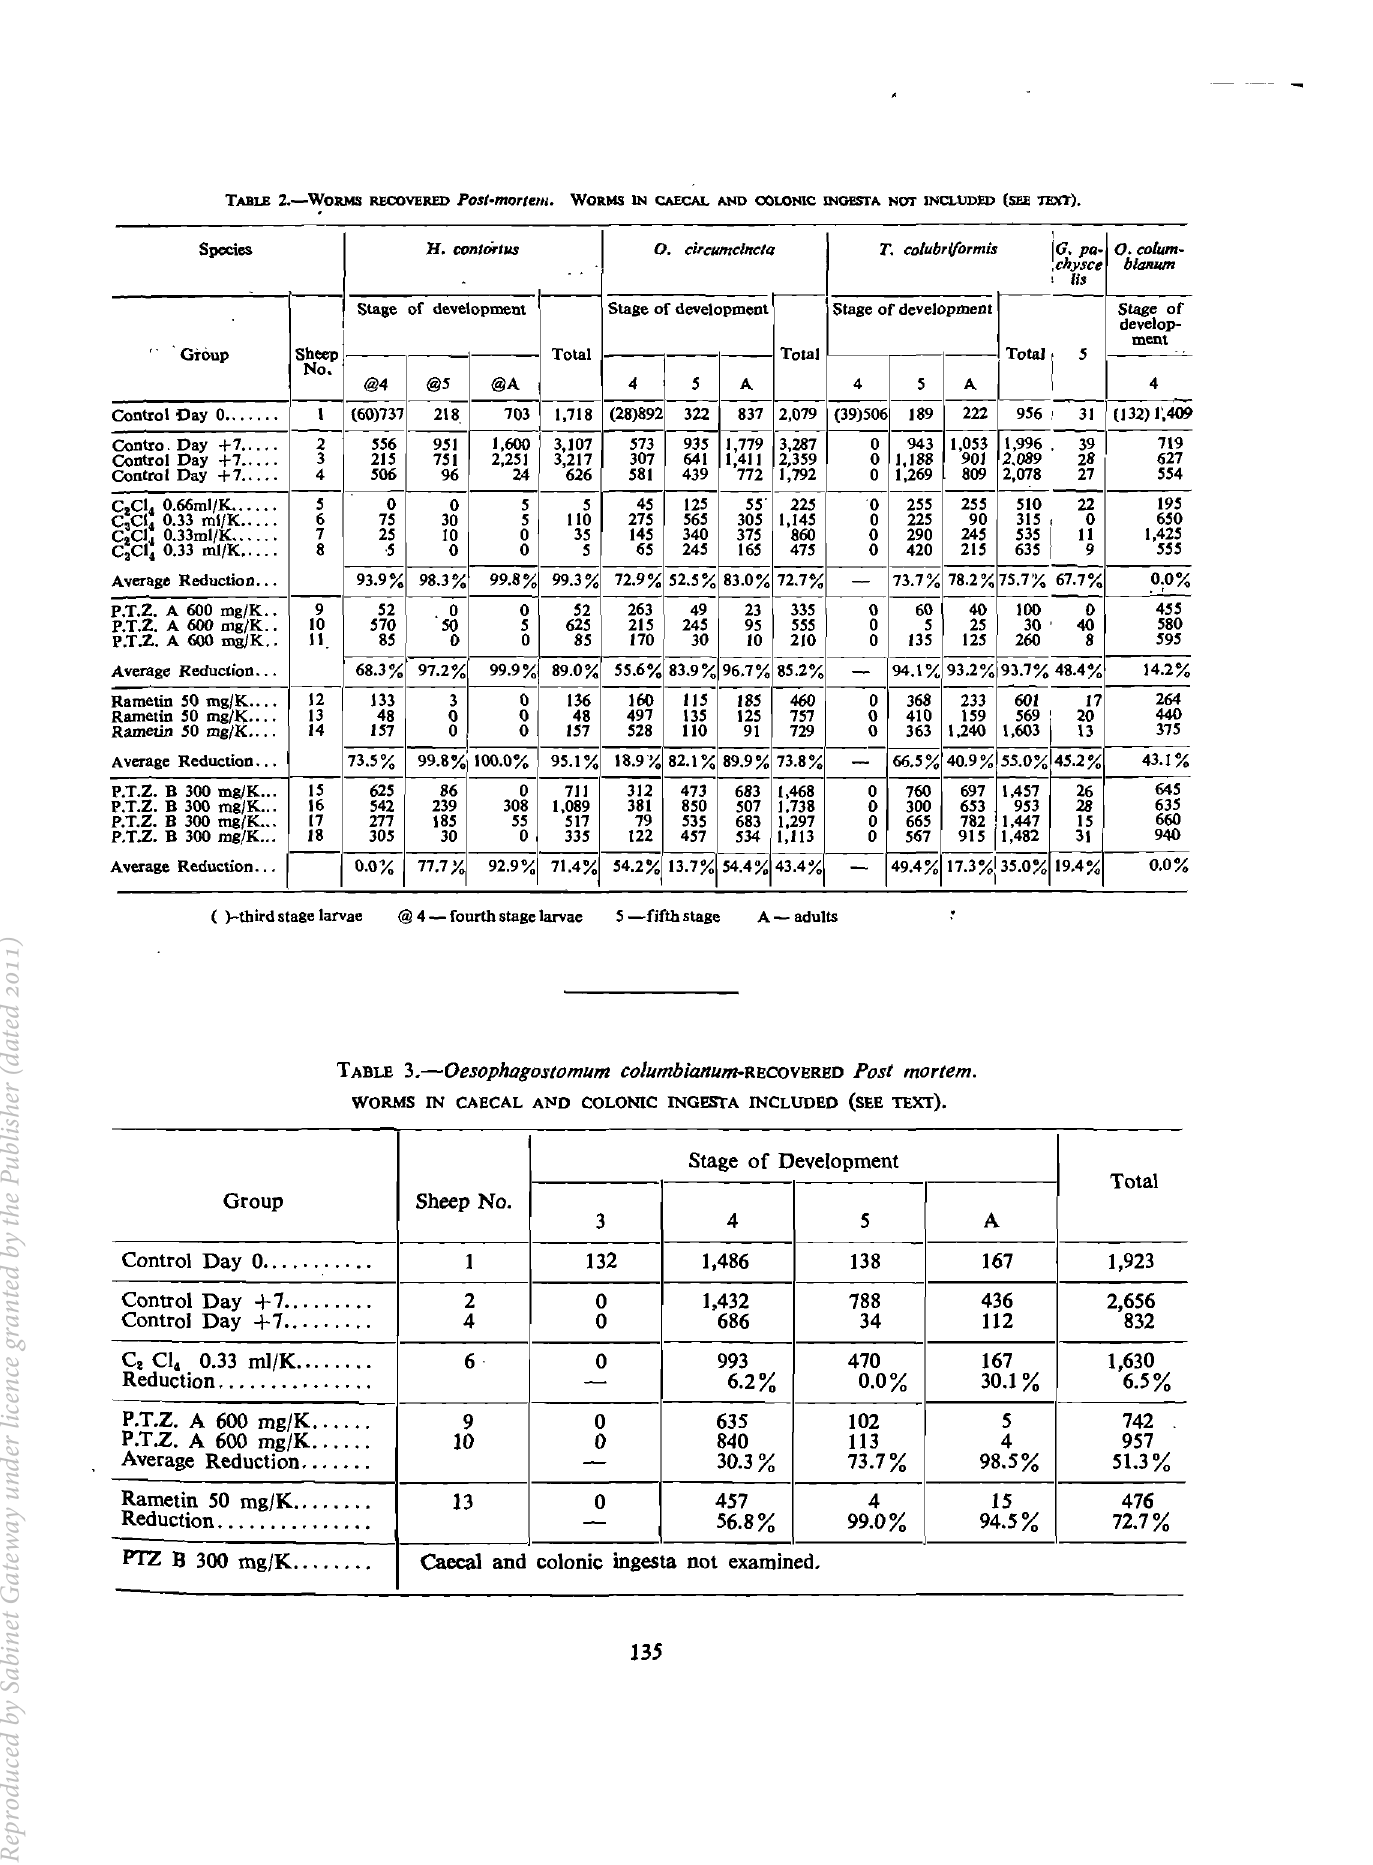
P.T.Z. A 600 mg/K ..